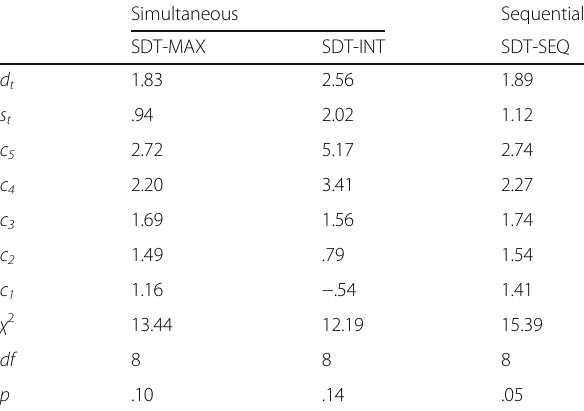
Table 5 Parameter estimates from fitting SDT-MAX and SDT-INT to the simultaneous data and SDT-SEQ to the sequential data from experiment